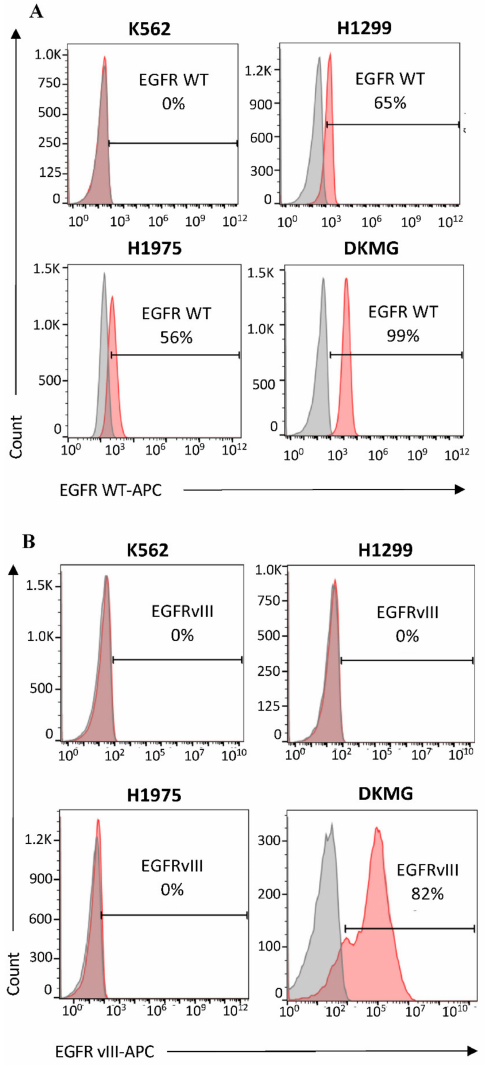
Figure 1. Detection of EGFR WT and EGFRvIII expression in K562, H1299, H1975, and DKMG cells by flow cytometry . Cells were incubated with ( A ) anti-human EGFR WT-APC or ( B ) anti- human EGFRvIII antibodies for 1 h at 4 ◦ C, and were washed and analyzed by flow cytometry. The gray curves are unstained cells, and the red curves indicate positive cells for EGFR wt or EGFRvIII. For each sample, 20,000 cells were examined. The data shown are from one experiment that is representative of three repeated